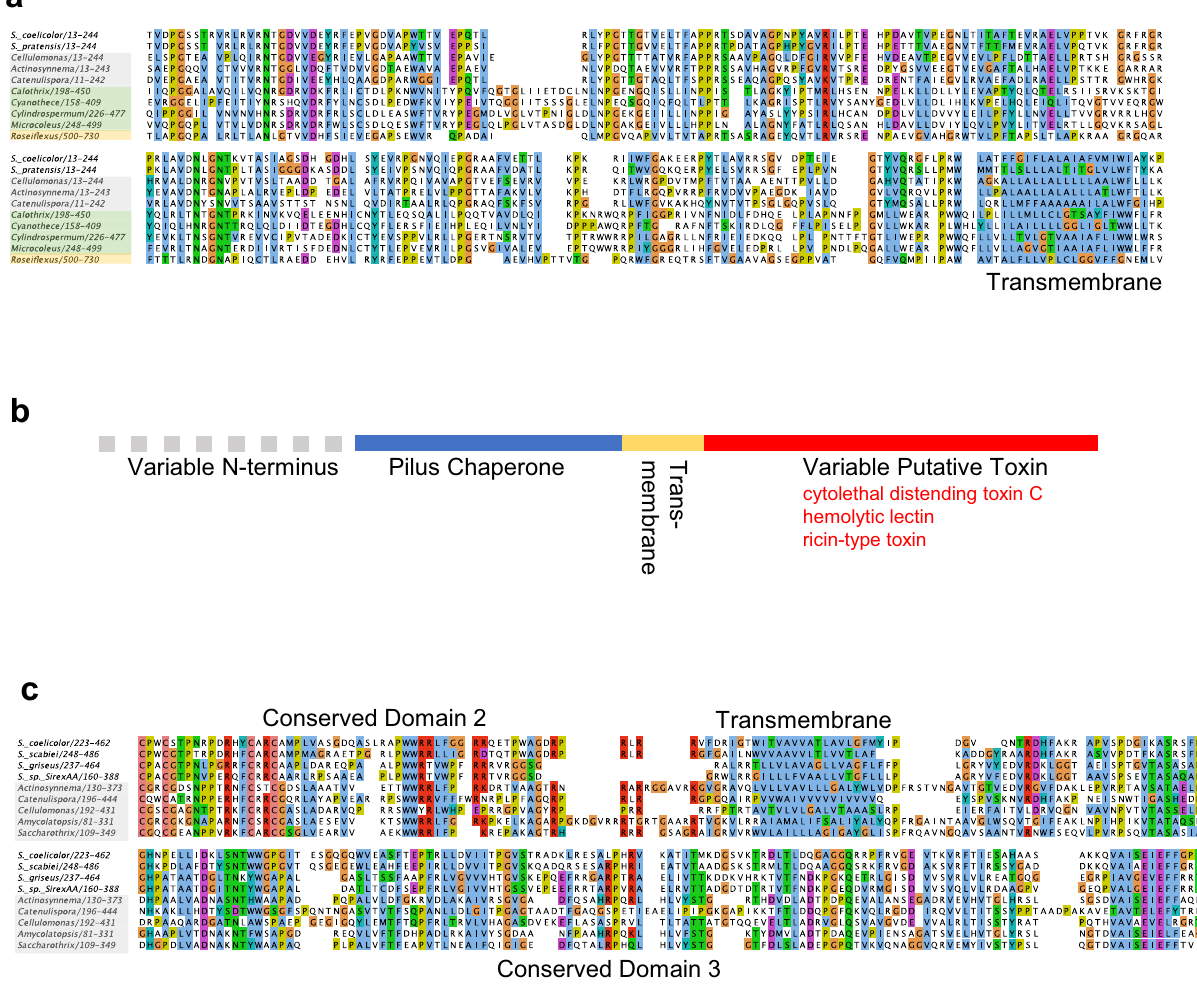
Fig. 6 | Conservation oftheputativetoxin and fi ber ofthe Sco eCIS. a A diverse selection of hits from a BLAST search initiated with Sco4256, the putative toxin, were aligned and analyzed by HHpred. Sequences shown are from Streptomyces species (unshaded), other Actinomycete species (shaded gray), Cyanobacteria (shadedgreen),andChor fl exi(shadedyellow).Allproteinsareassociatedwithtype IId systems and all generaare fi lamentous exceptfor Cyanothece . b A schematicof